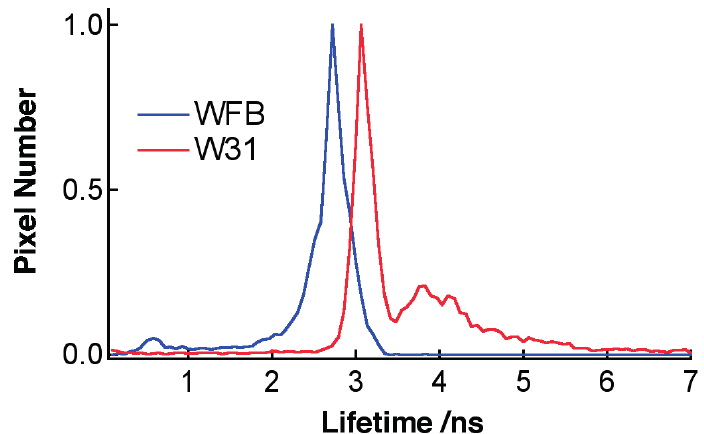
Figure 11. Histograms of the average fluorescence lifetime of Na-Ph-a in WFB (blue) and W31 (red)